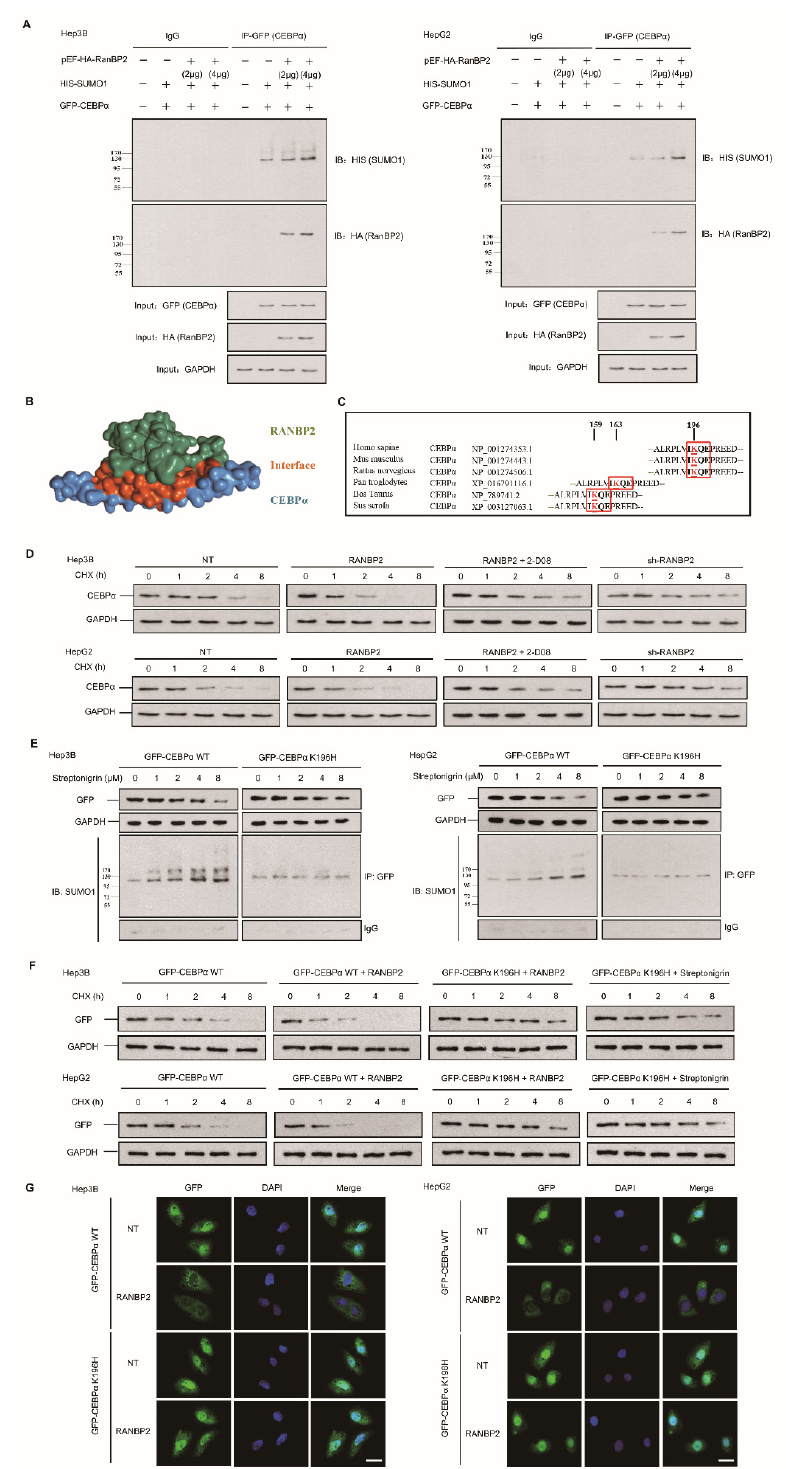
Figure 3. RANBP2-dependent SUMOylation of CEBP α promotes its instability in HCC cells. ( A ) RANBP2 exogenously co-precipitated CEBP α and increased SUMOylation of CEBP α in vitro. Hep3B and HepG2 cells were transfected with foreign pEF-HA-RanBP2 (2 and 4 µg in gradients),